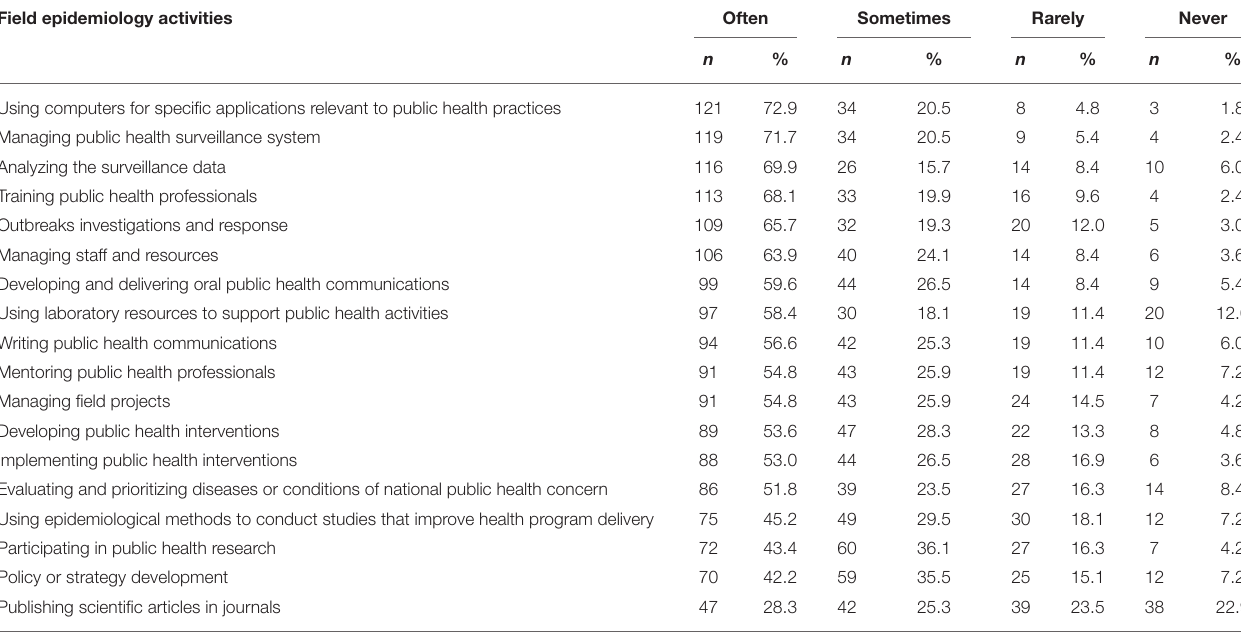
TABLE 2 | The extent of engagement of FETP graduates in field epidemiology